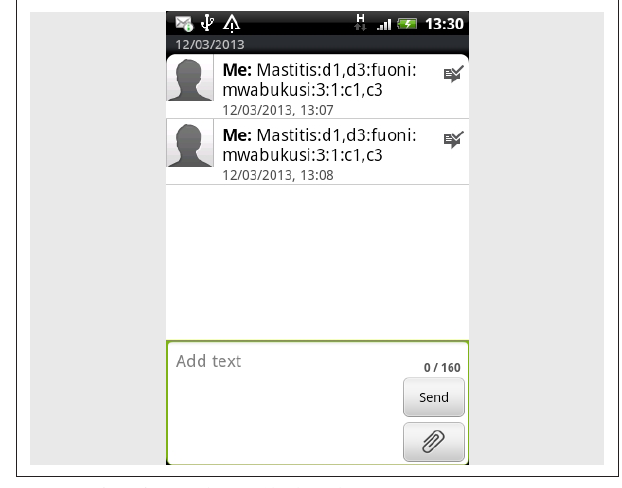
FIGURE 7: The short messaging service codes as they are appear on mobile phones, written in